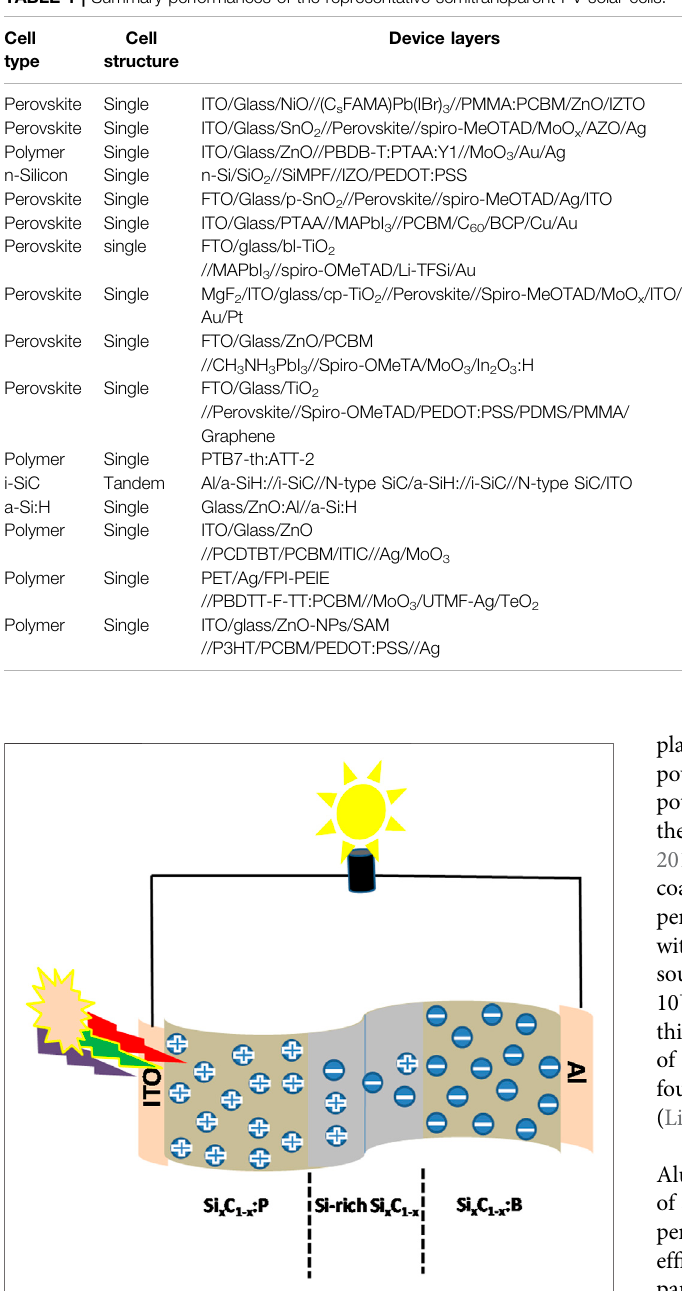
TABLE 1 | Summary performances of the representative semitransparent PV solar cells.